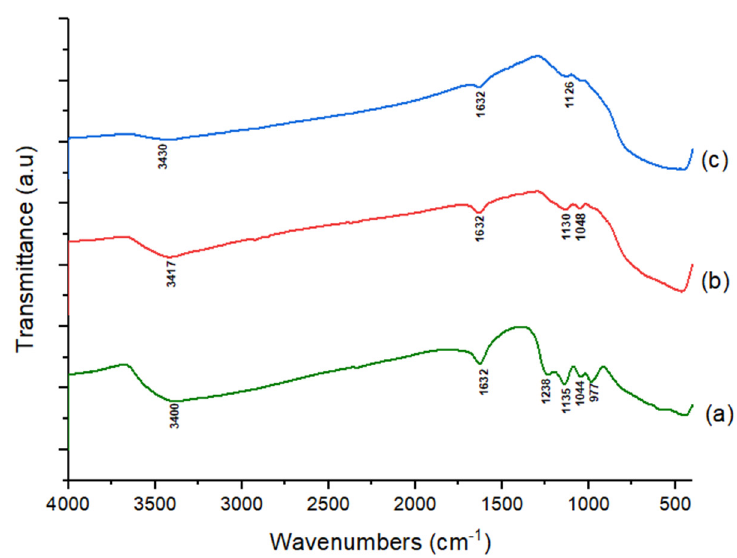
Figure 2. FTIR spectra of ( a ) TS-3-400, ( b ) TS-3-500, ( c ) TS-3-600.